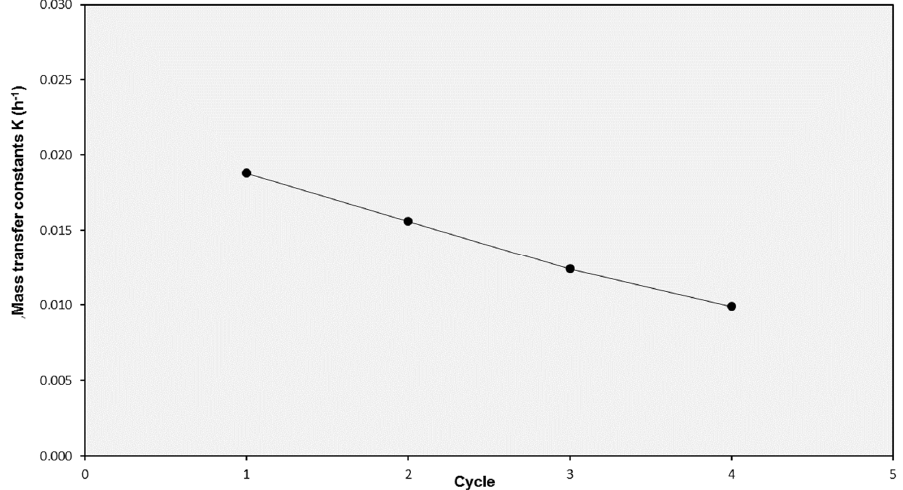
Figure 4. Evolution of the mass transfer coefficient K for lignosulphonate solution in SILMs used in consecutive cycles.